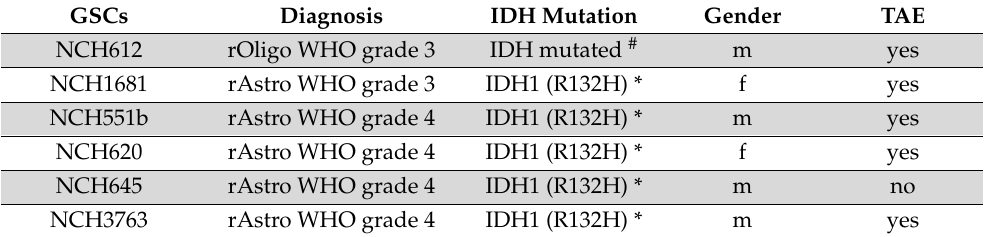
Table 1. Characteristics of parental glioma patients and tumor-derived glioma stem-like cells. GSCs